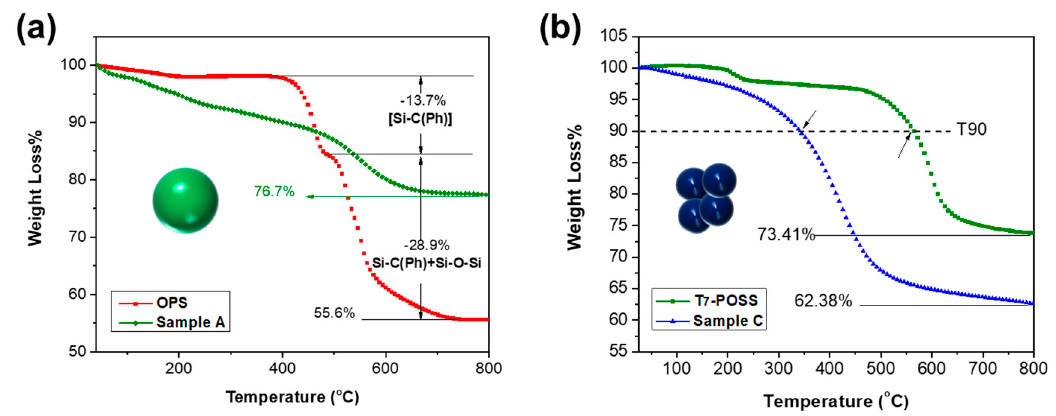
Figure 7. The expected chemical structure of the porous materials: ( a ) sample A, ( b ) sample B, and ( c ) sample C.